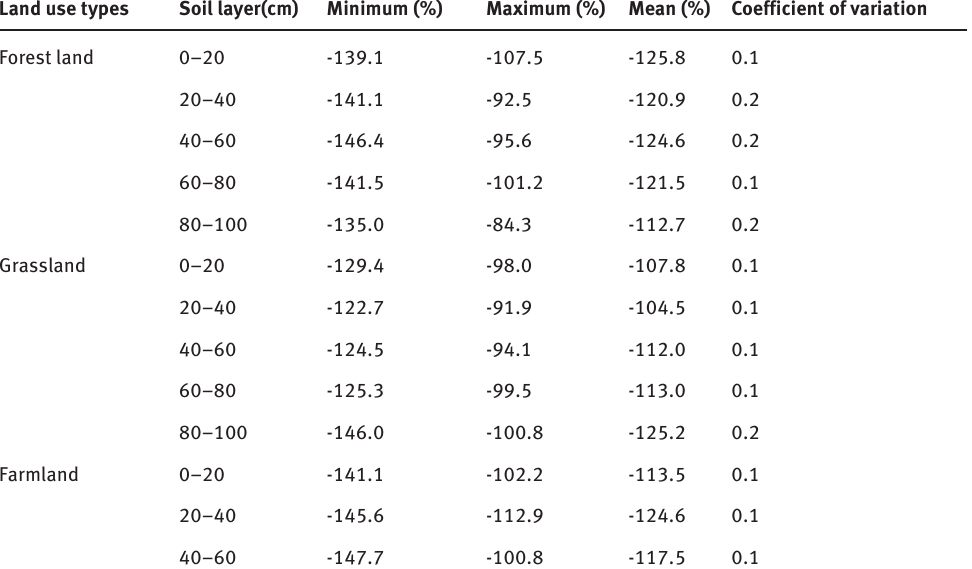
Table 3: Statistical characteristics of the hydrogen isotopes in soil moisture of different land use types and soil depth. Land use types Soil layer(cm) Minimum (%) Maximum (%) Mean (%) Coefficient of variation Forest land